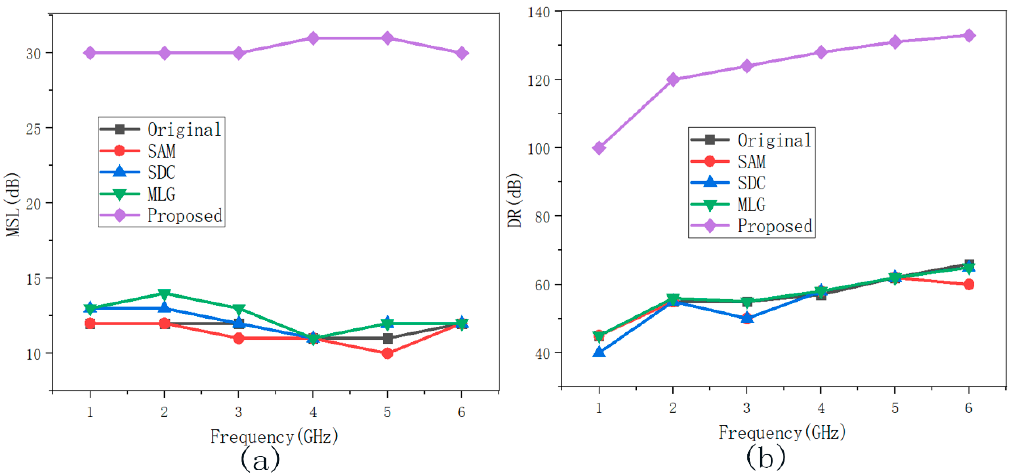
Figure 8. The MSL/DR results for two interference sources in Figure 6 at 1–6 GHz before and after denoising. ( a ) MSL with different frequencies and ( b ) DR with different frequencies.